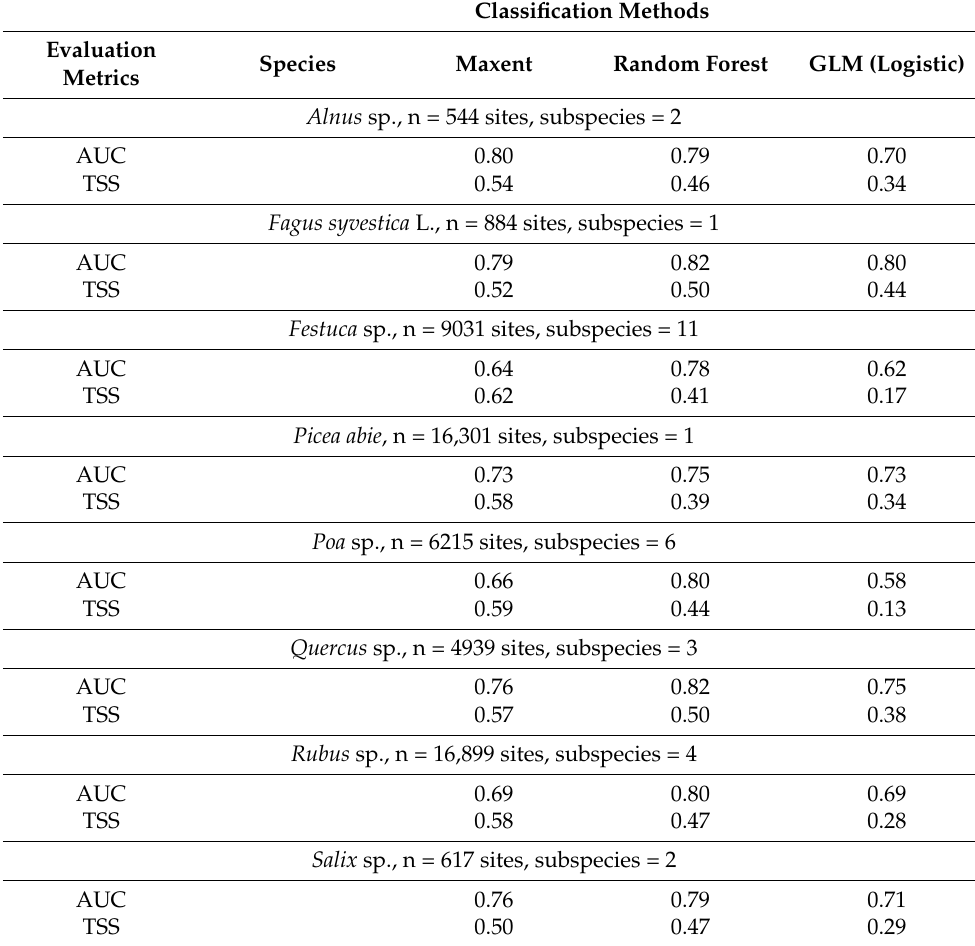
Table 4. Model evaluation for selected